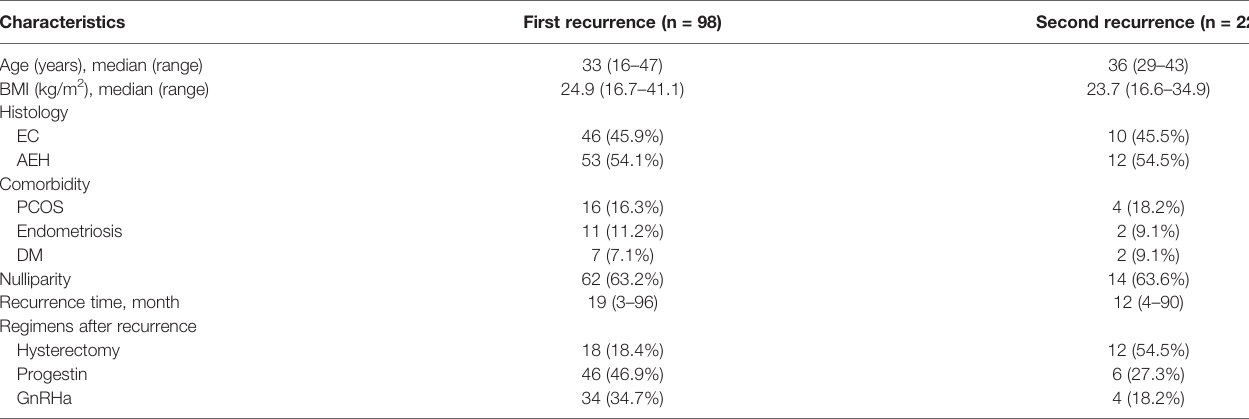
TABLE 1 | Patient ’ s